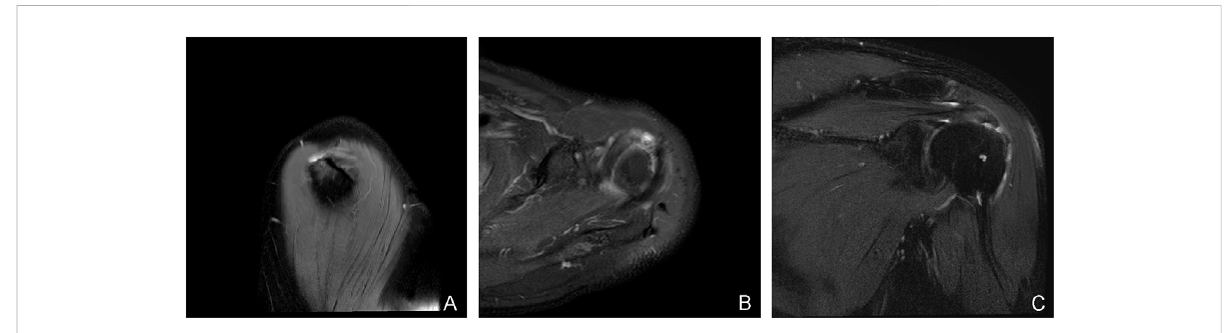
FIGURE 1 AtypicalcaseofanL-shaped tear:a71-year-oldmanwith diffusetendinitisofthesupraspinatustendonintheleftshoulder andalocalizedfull- thickness tear of the tendon anterior to the tuberosity insertion. Slightly high signal intensity can be seen in the supraspinatus tendon, and an L-shaped watery tear signal canbe seen in theanterior tendon atthe insertion point of thehumeral tubercle. (A) theoblique sagittal view of T2lipid- suppressing sequence; (B) the axial view of proton density sequence; (C) the oblique coronal view of T2 lipid-suppressing sequence.